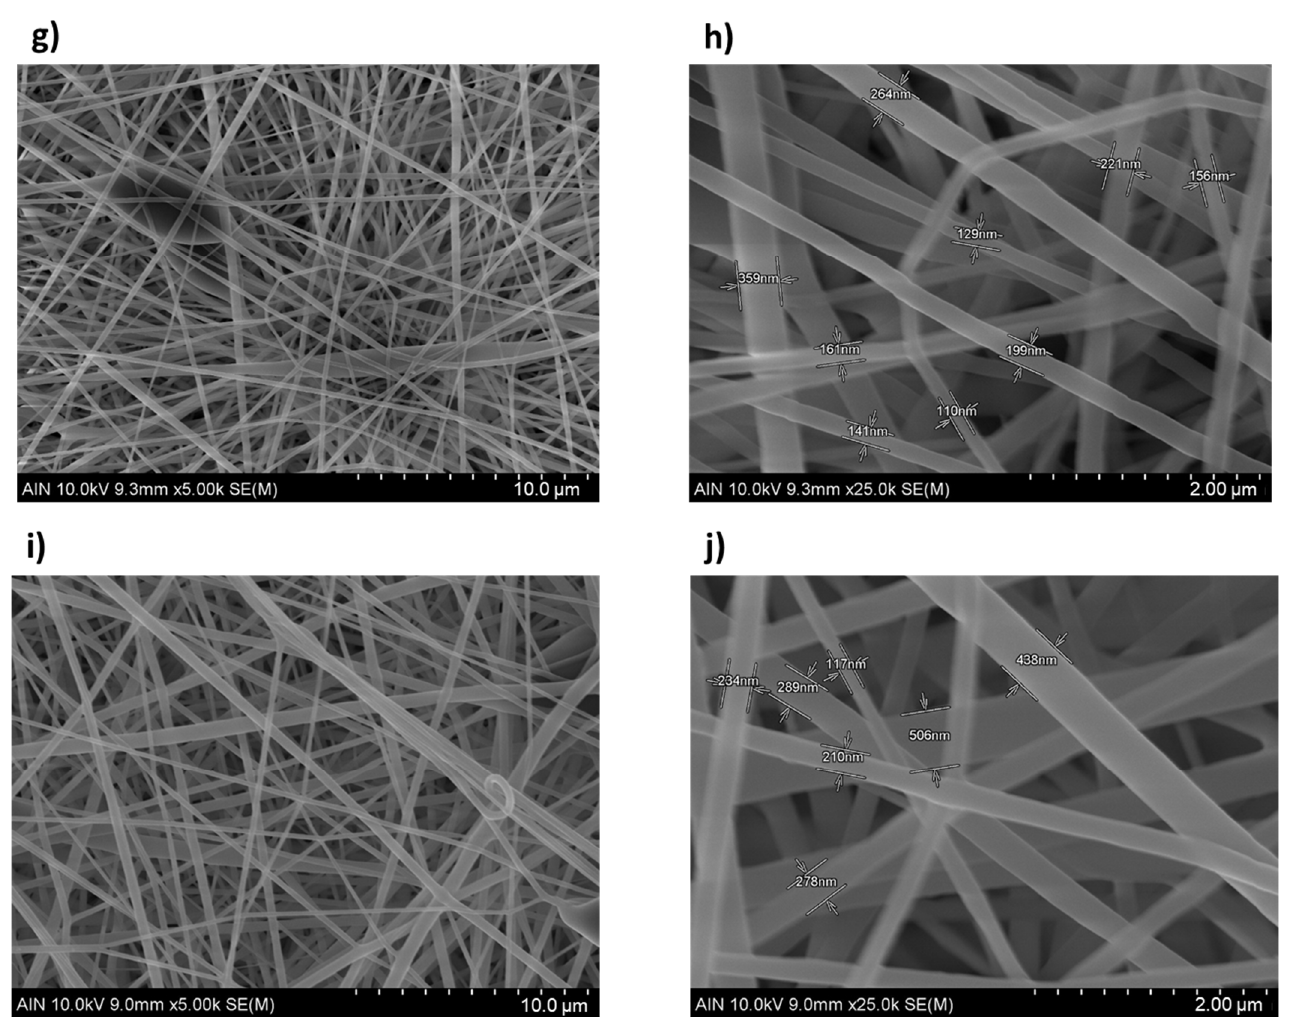
Figure 10. Scanning electron microscopy (SEM) images representing the surface morphology of the electrospun mats for sample S1 ( a , b ) (500 µL/h and 13.2 KV), S2 ( c , d ) (1000 µL/h and 15.3 KV), S3 ( e , f ) (2000 µL/h and 17.7 KV), S4 ( g , h ) (3000 µL/h and 19.5 KV), and sample S5 ( i , j ) (5000 µL/h and 20.5 KV) at the scale of 10 µm ( a , c , e , g , i ) and 2 µm ( b , d , f , h , j ), respectively.